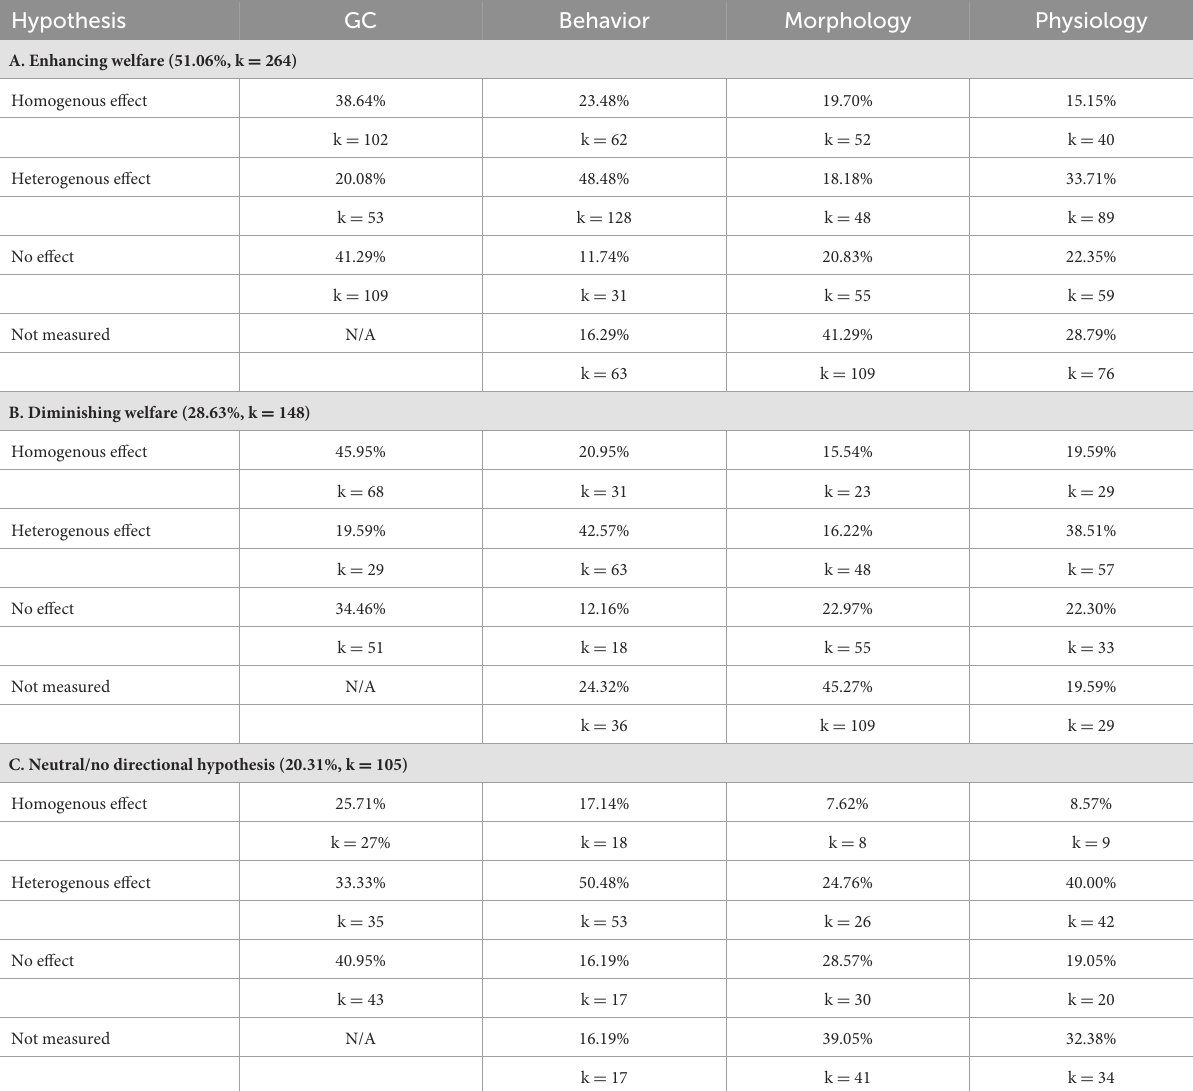
TABLE 2 Categorization of the proportion and total numbers of experiments (517 experiments in 509 studies) of the research hypothesis (A, B, C) stated by the respective authors of the reviewed studies reporting an effect on GC levels and/or the three additional assessment parameter, behavior, morphology and